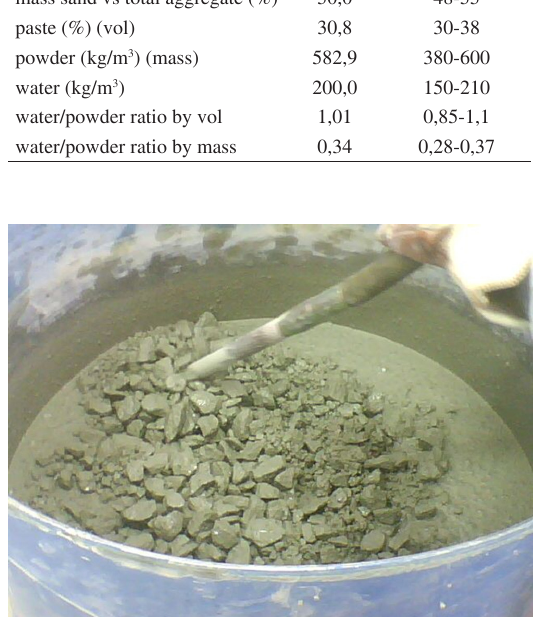
Figure 4. Results of the slump test of all the test